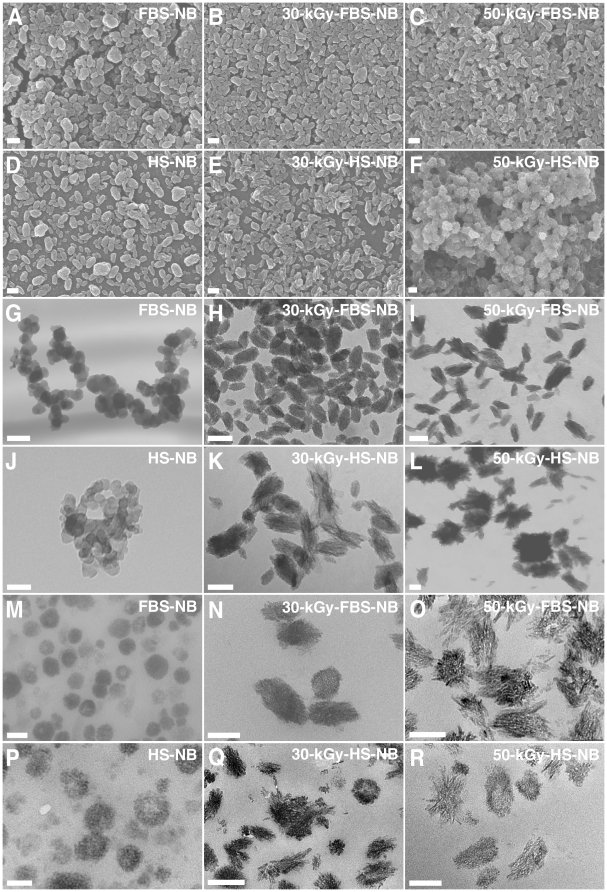
NB cultured from either untreated serum or γ-irradiated serum display similar morphologies under electron microscopy.NB were collected from a 2-month incubation of the indicated serum at 10% as seen in Figure 6. Following centrifugation and washing steps, the NB specimens were processed for (A–F) SEM, (G–L) TEM, or (M–R) thin-section TEM as described in the
Materials and Methods
. NB obtained from either untreated or γ-irradiated serum appeared as small, rounded and elongated particles displaying varying degrees of crystallinity. Scale bars: 50 nm (J, P); 100 nm (I, K, M–O, R); 200 nm (A–E, G, H, L, Q); 500 nm (F).